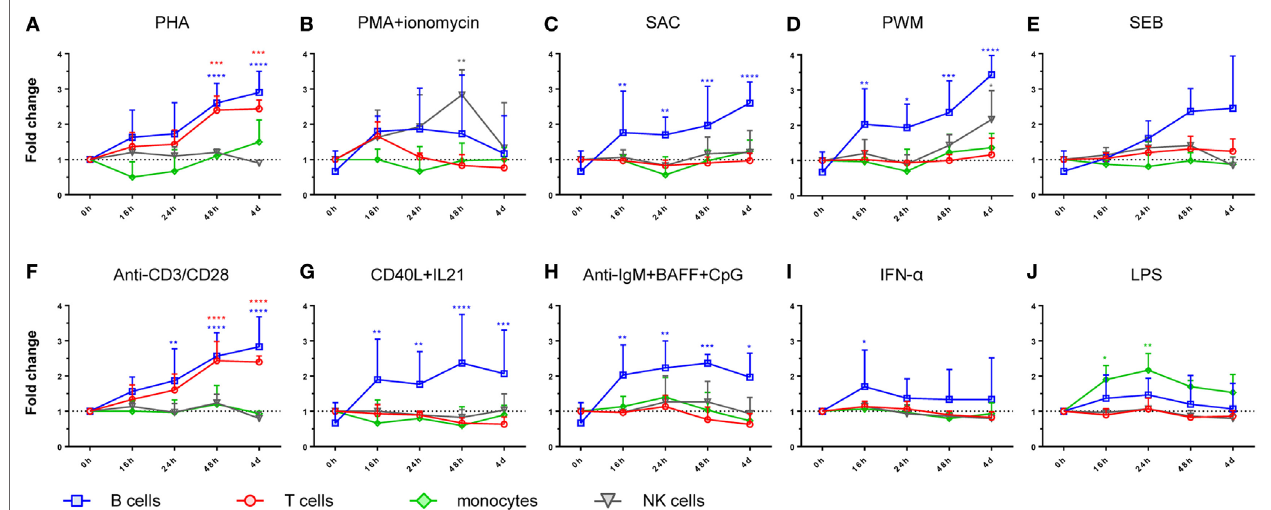
FIGURe 2 | Time course of LRBA protein expression in peripheral blood mononuclear cells subsets. B-lymphocytes, T-lymphocytes, NK cells, and monocytes are represented in blue, orange, green, and gray, respectively. Values are presented as mean fluorescence intensity fold changes from time 0 h, which was normalized to one. Statistical analysis was done comparing 0 h with 16, 24, 48, or 4 days, respectively, after stimulation with (A) phytohaemagglutinin (PHA), (B) PMA + ionomycin, (C) SAC, (d) pokeweed mitogen (PWM), (e) staphylococcal enterotoxin B (SEB), (F) anti-CD3/anti-CD28, (G) CD40L + IL-21, (h) anti-IgM + BAFF + CpG, (I) IFN-alpha, and (J) lipopolysaccharide (LPS). Statistical significance of the different cell subsets are represented with the same color as the cell subpopulation, i.e., blue, orange, green, and gray, for B-lymphocytes, T-lymphocytes, monocytes, and NK cells, respectively. All stimulation conditions and time points were performed in three samples independently.